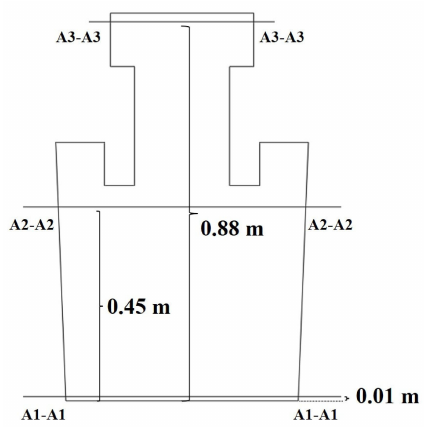
Figure 10. Schematic diagram of the monitoring cross